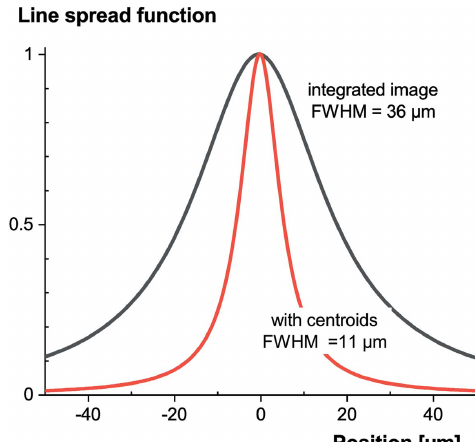
Figure 19 LSF of an 11 m m-thick GOS:Tb scintillating screen with an integrating image and with a reconstructed image based on centroids of single X-ray